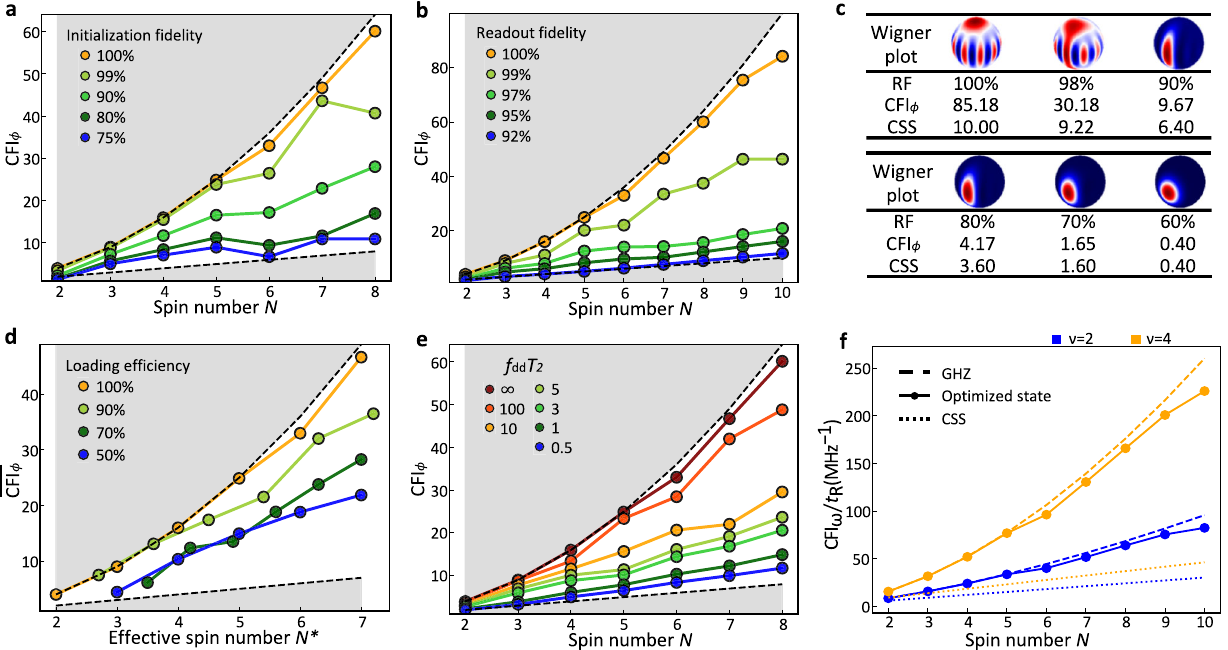
Fig. 4 Performance under imperfections. a CFI ϕ under fi nite initialization fi delity (IF). IF ¼ N " (cid:2) N # , where N ↑ ( N ↓ ) denotes the number of spins in N the "j i ( #j i ) state at the beginning of the sensing protocol in Fig. 1(b). b CFI ϕ under fi nite readout fi delity (RF). RF = 1 − p ( ↓ ∣ ↑ ) = 1 − p ( ↑ ∣ ↓ ). c Optimized Wigner functions and CFI ϕ of a 10-spin state versus different readout fi delities (RF). For comparison, the row `CSS' represents the CFI ϕ for a coherent spin state given the same RF. See Supplementary Fig. 9 for more information. d Average CFI ϕ under fi nite loading ef fi ciency. Effective spin number N * is the averagely loaded spin number for a given con fi guration and loading ef fi ciency. e CFI ϕ in the presence of decoherence in the entangler. f Ramsey protocol ’ s results of the generated states when considering non-Markovian noise during signal accumulation (see Supplementary Fig. 8 for more details). All data correspond to the optimized states from 2D square lattice con fi guration using a 5-layer circuit.